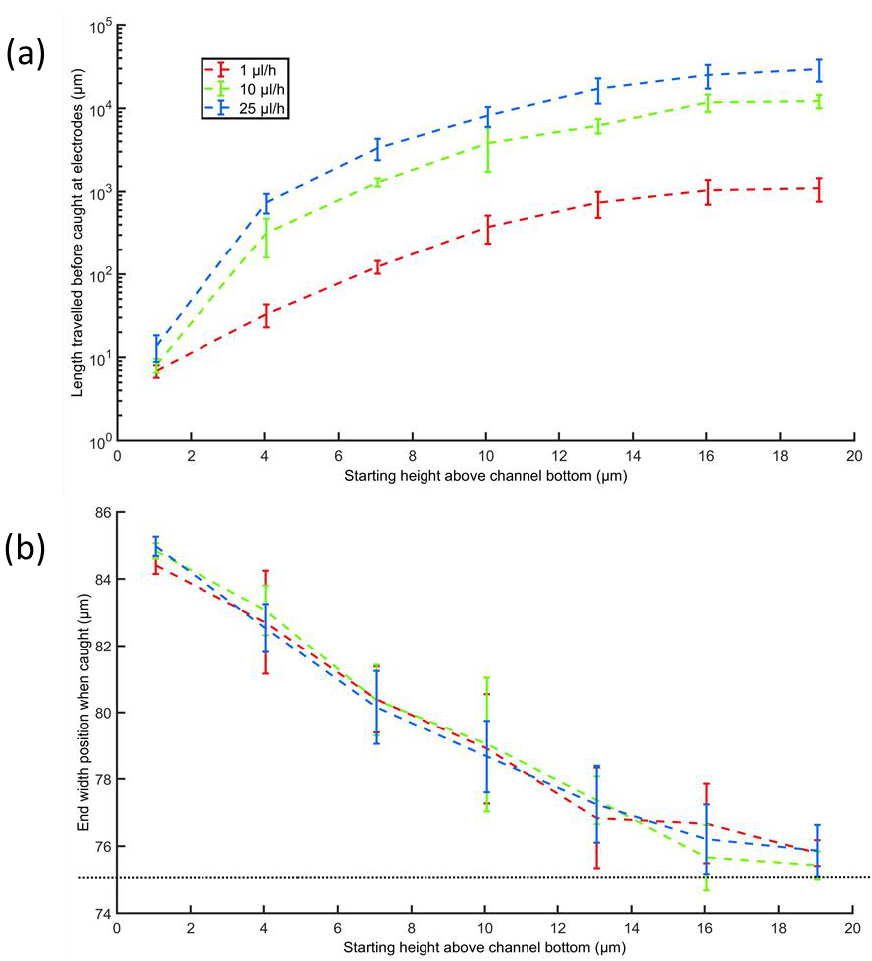
along the channel height.